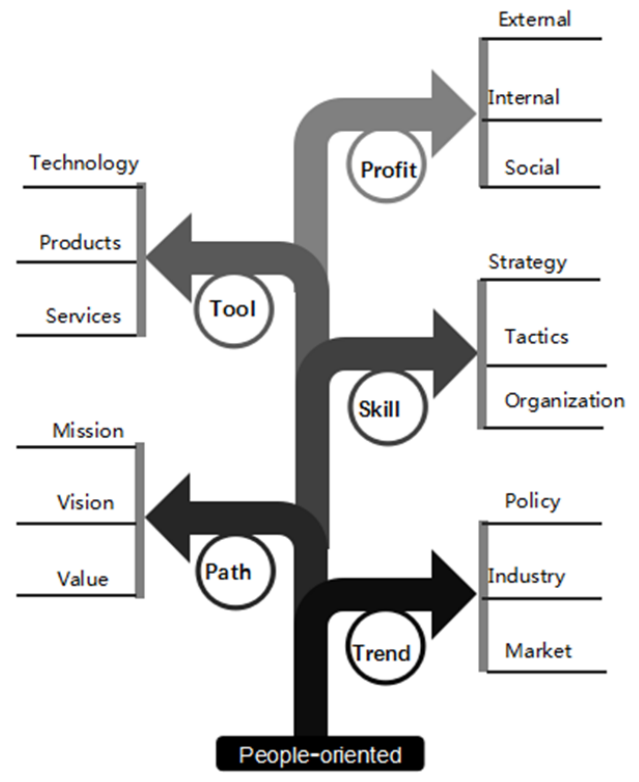
Figure 1. Business compass mind map.